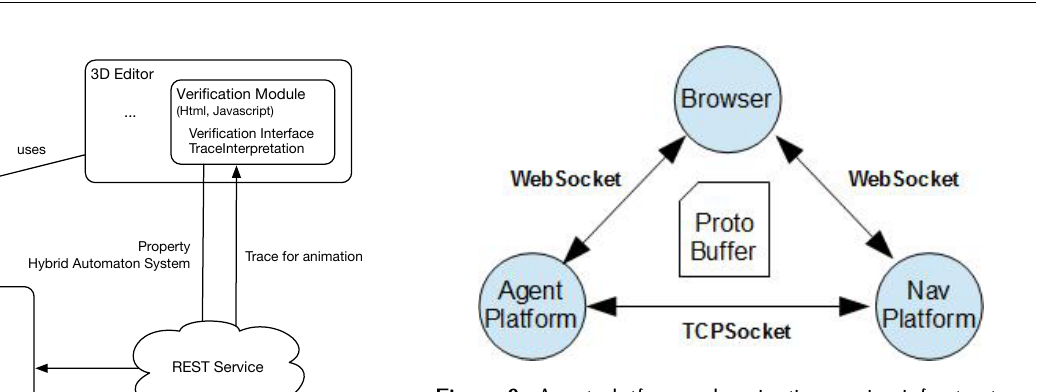
Figure 9. Agent platform and navigation service infrastructure